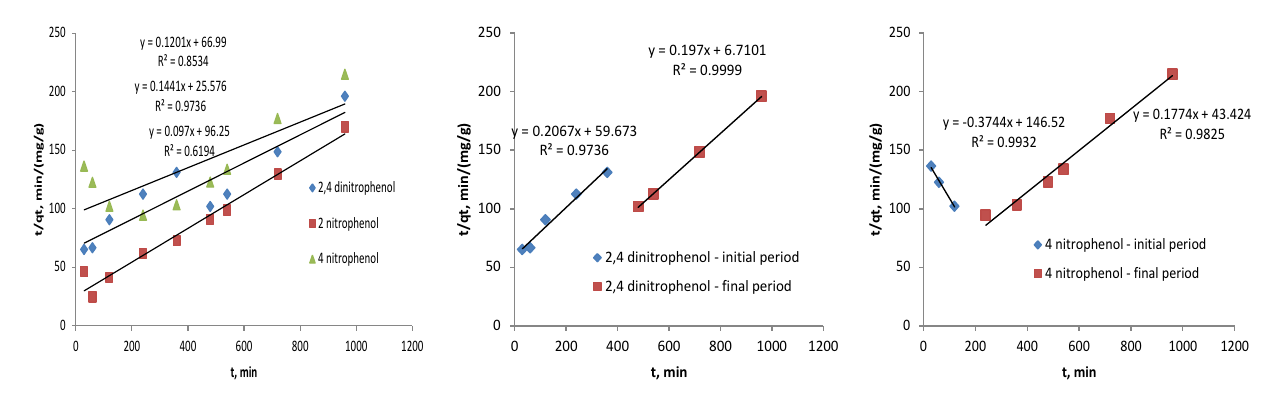
Fig. 10 Second order model of phenols on char